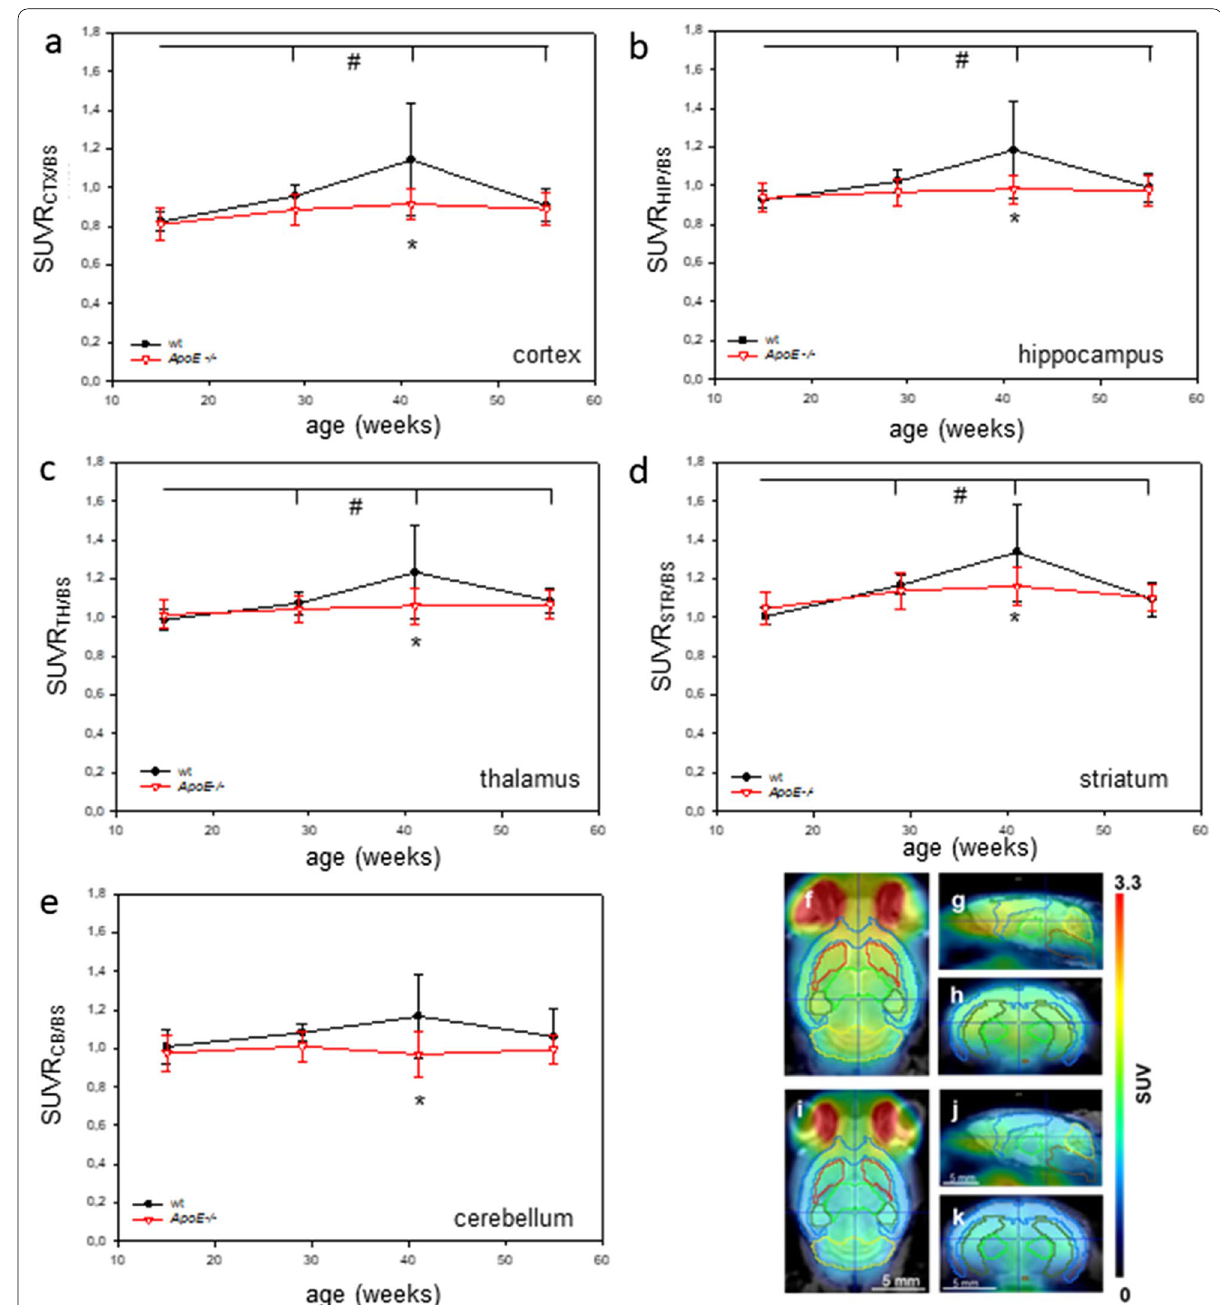
Fig. 4 Target-to-brain stem ratio of [ 18 F]FDG uptake in the cortex (SUVR CTX/BS ), hippocampus (SUVR HIP/BS ), thalamus (SUVR TH/BS ), striatum (SUVR ST/ BS ), and cerebellum (SUVR CB/BS ) of wild type (wt; n = 8) and Apolipoprotein E-deficient ( ApoE − / − ; n = 8) mice ( a – e ). Values are given as mean ± SD; ANOVA for repeated measurements followed by Holm-Sidak comparison test: * p < 0.05 versus wt, # p < 0.05 versus 15 weeks. Visual comparison of [ 18 F]FDG uptake in the brain of wt ( f – h ) and ApoE / mice ( i – k ). Transversal ( f , i ), sagittal ( g , j ), and coronal ( h , k ) [ 18 F]FDG-PET/CT and MRI with M. − − Mirrione VOI template overlay and fusion (template: cortex—blue, striatum—red, thalamus—light green, hippocampus—dark green, cerebellum— yellow, brain